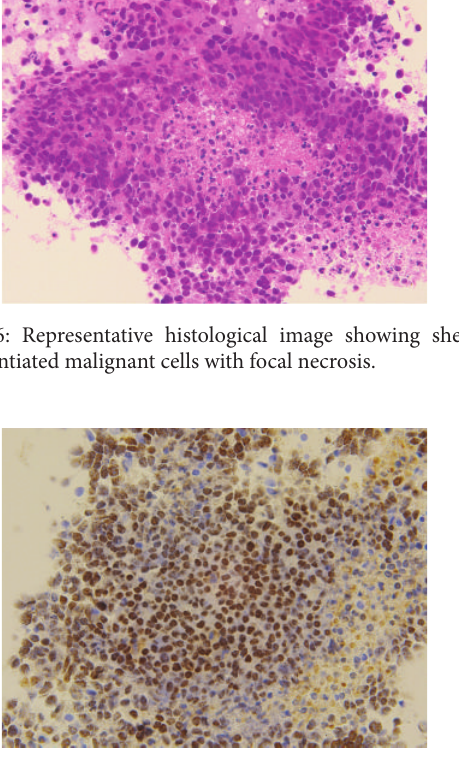
Figure 7: Immunohistochemistry showing a nuclear staining pat- tern for